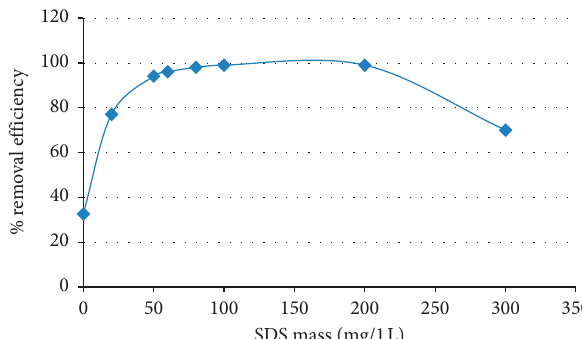
3, time 60min, and (cid:30) (cid:30)